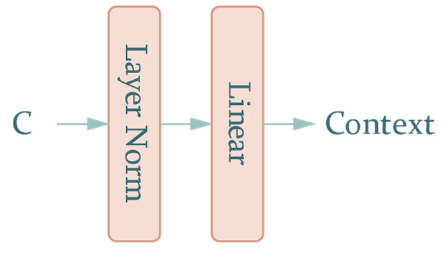
Figure 6. The projection network of C l × m